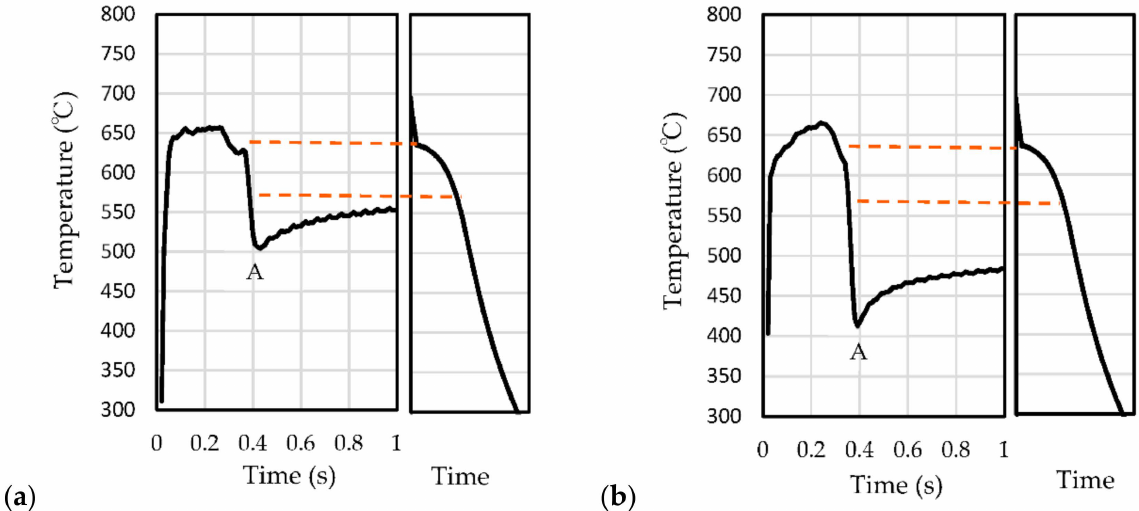
Figure 3. Cooling curves (time–temperature plots) for Al-4.8%Mg cast using VHSTRC and insulating mold. The left and right sides of each panel are the cooling curves for the VHSTRC and the insulating mold, respectively. The rolling speed was 30 m/min, and the roll load was 20 kN. The dashed lines show the liquidus and solidus temperatures obtained using the insulating mold. ( a ) Mild steel roll and ( b ) copper